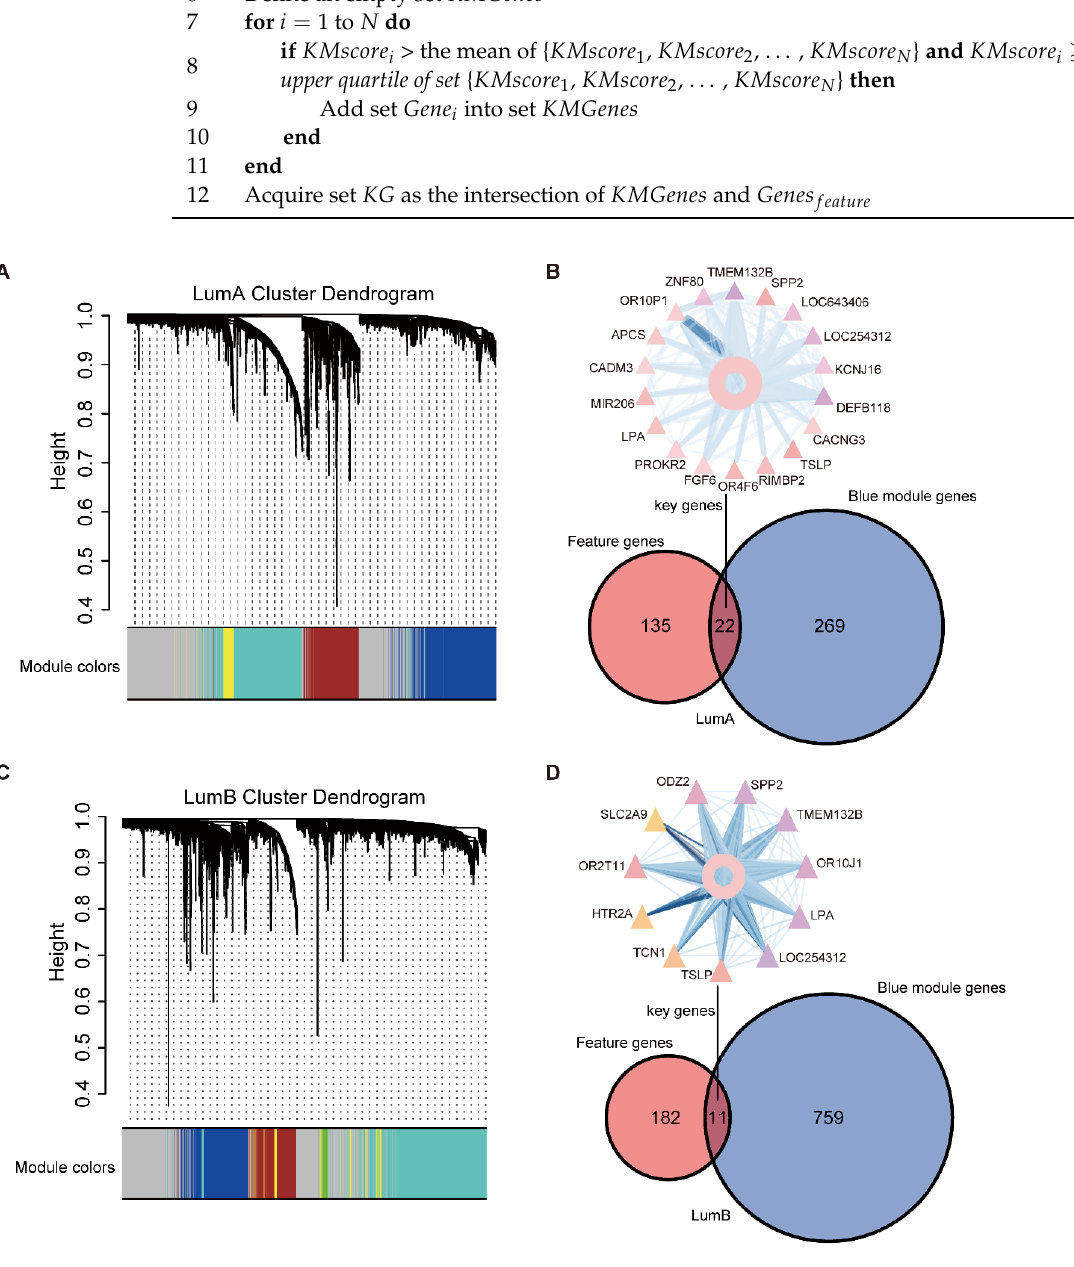
Figure 2. Acquisition of “key gene”. ( A ) Differential DNA methylation module in luminal A. ( B ) 22 “key genes” for subgrouping luminal A. ( C ) Differential DNA methylation module in luminal B. ( D ) 11 “key genes” for subgrouping luminal B.